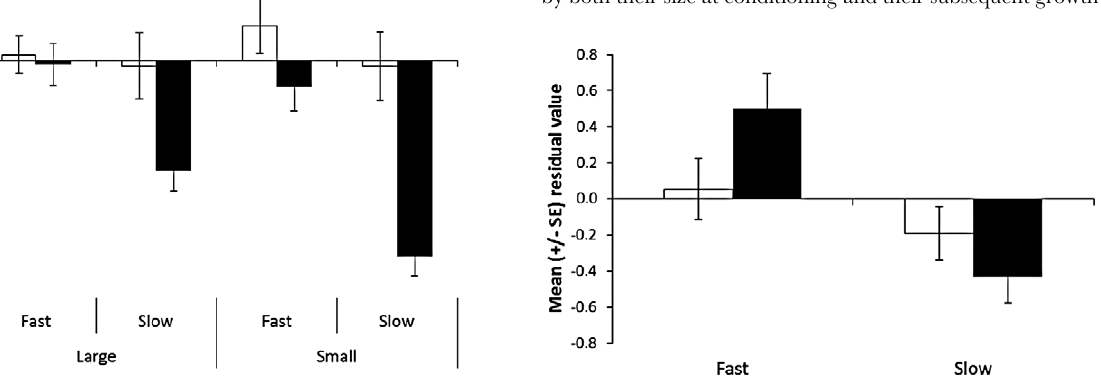
Figure 5. Mean residual value from tadpoles exposed to salamander odour 8 days post conditioning. Large (open bars) and small (black bars) tadpoles were maintained on a fast or slow growth trajectory post-conditioning. Residuals were obtained from a linear regression between tadpoles’ intensity of antipredator response when exposed to salamander odour and their size.